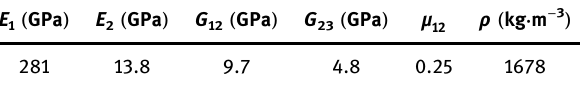
Table 2: The parameters of composite material